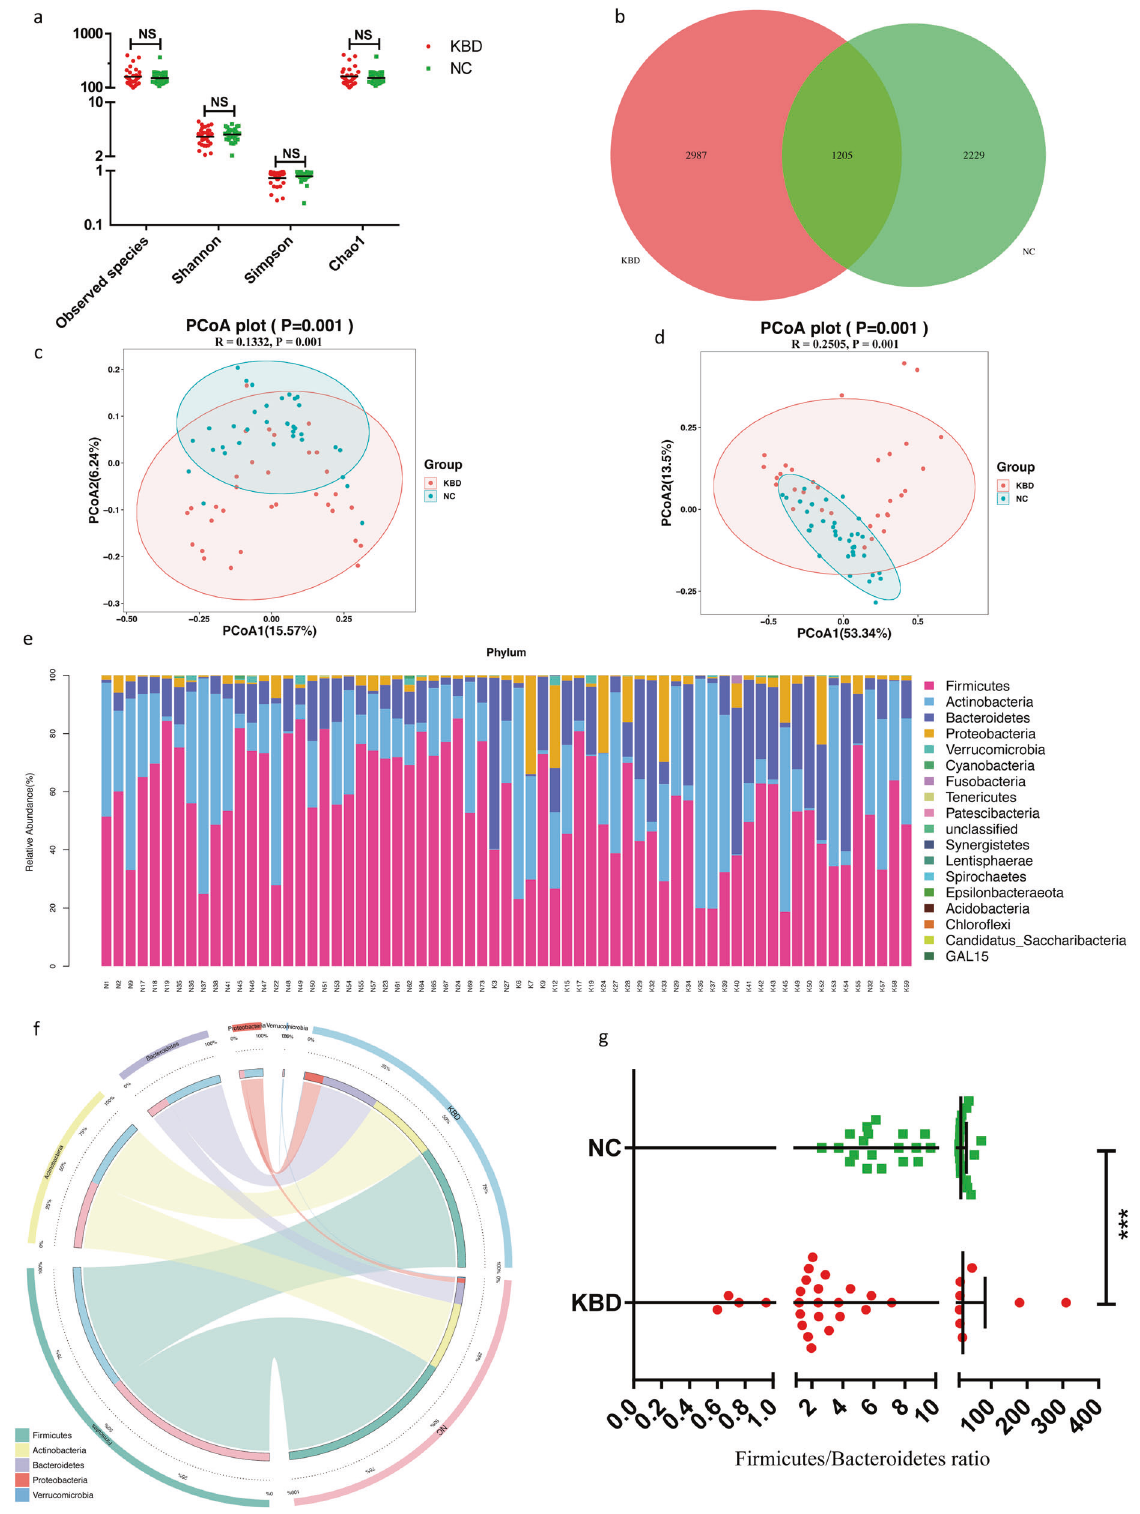
groups (Supplementary Table S7). The species Bacteroides vulgatus, Bacteroides stercoris , and Bacteroides dorei had signi fi - cantly decreased abundance in the grade I KBD group compared to those in the NC group (Fig. 3d, Table S7), Prevotella copri, Prevotella copri-CAG:164, Prevotella SP-AM23-5, and